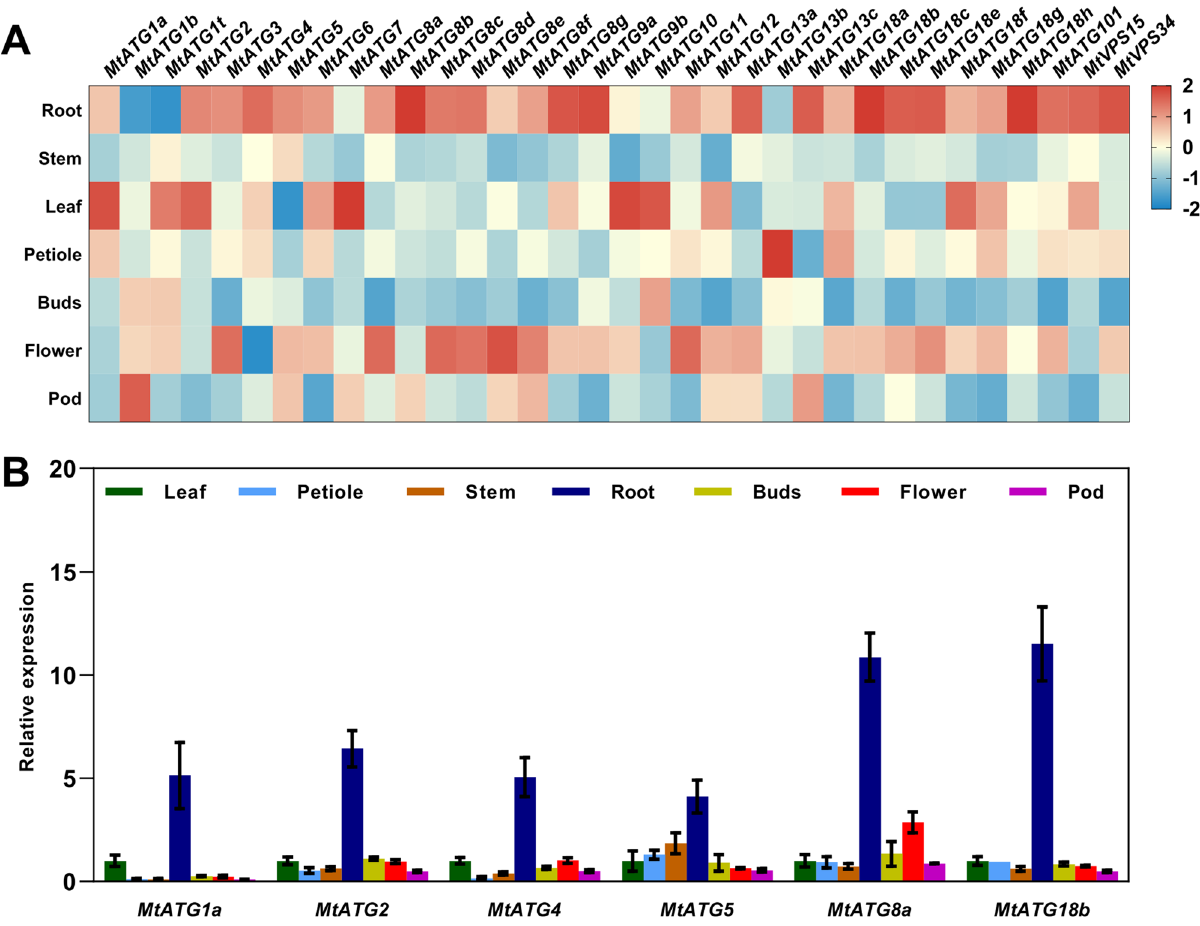
Figure 6. Expression patterns of MtATGs in different tissues. ( A ) Expression patterns of MtATGs in different tissues. Roots, stems, leaves, petioles, and shoot buds were harvested from multiple M. truncatula plants at 28 days after planting, and fully opened flowers and pods (2.5–9.0 mm in length) were collected. ( B ) qRT- PCR validation of MtATGs expression in different tissues. MtACTIN was used as a reference gene. Error bars represent SD of three independent experiments. Significant differences were indicated with an asterisks (*), P <